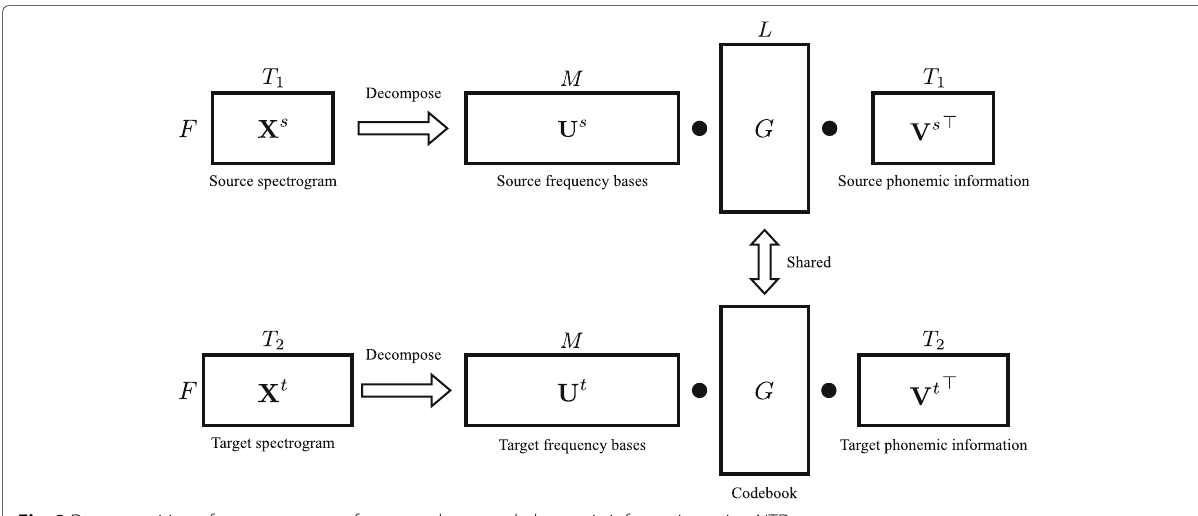
Fig. 2 Decomposition of spectrograms to frequency bases and phonemic information using